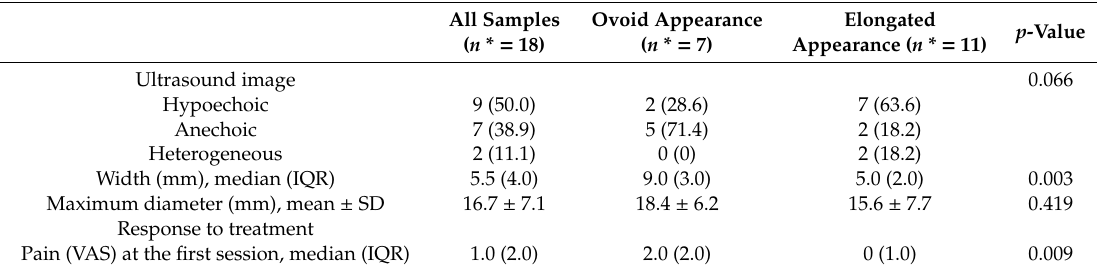
Table 2. Predictors of time to remission of the fistula (without relapse within six months) in Cox’s proportional hazards model.